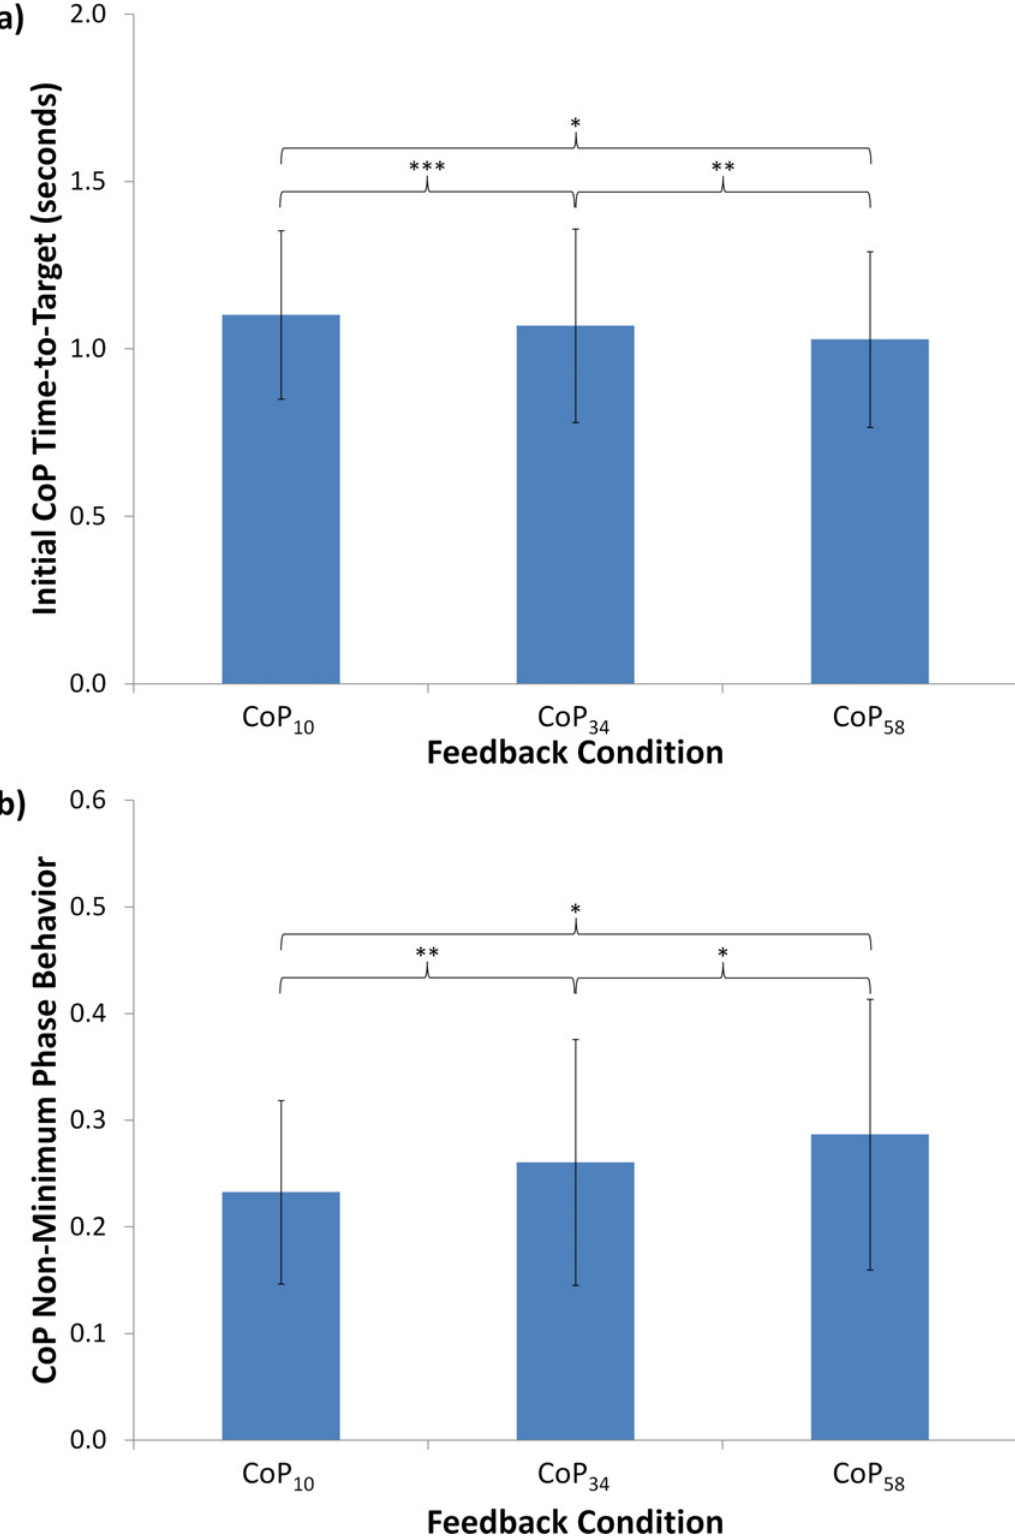
Fig 5. Shift performance results. Average values for shift performance based on (a) initial CoP time-to-target and (b) CoP non-minimum phase behavior across the three filtered feedback conditions. Bars indicate one standard deviation. * : p < 0.0001; ** : p < 0.01; *** : p <